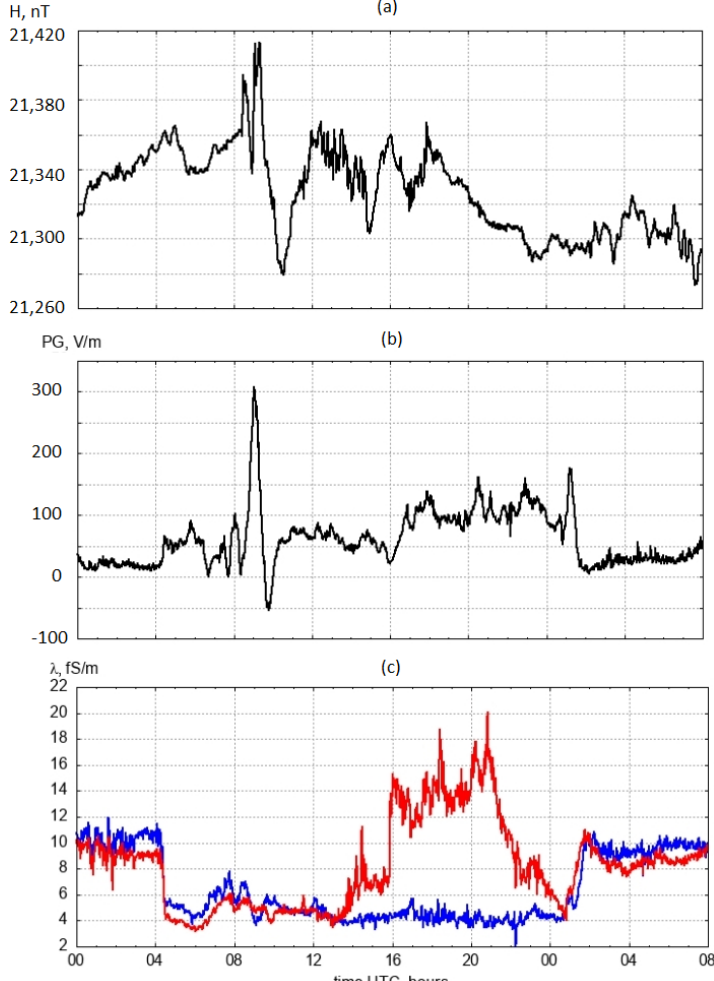
Figure 12. The effect of the magnetic storm 5 April 2010: ( a ) H-component of the magnetic field; ( b ) PG values; ( c ) electrical conductivity of the air caused by positive ions (red line) and negative ions (blue